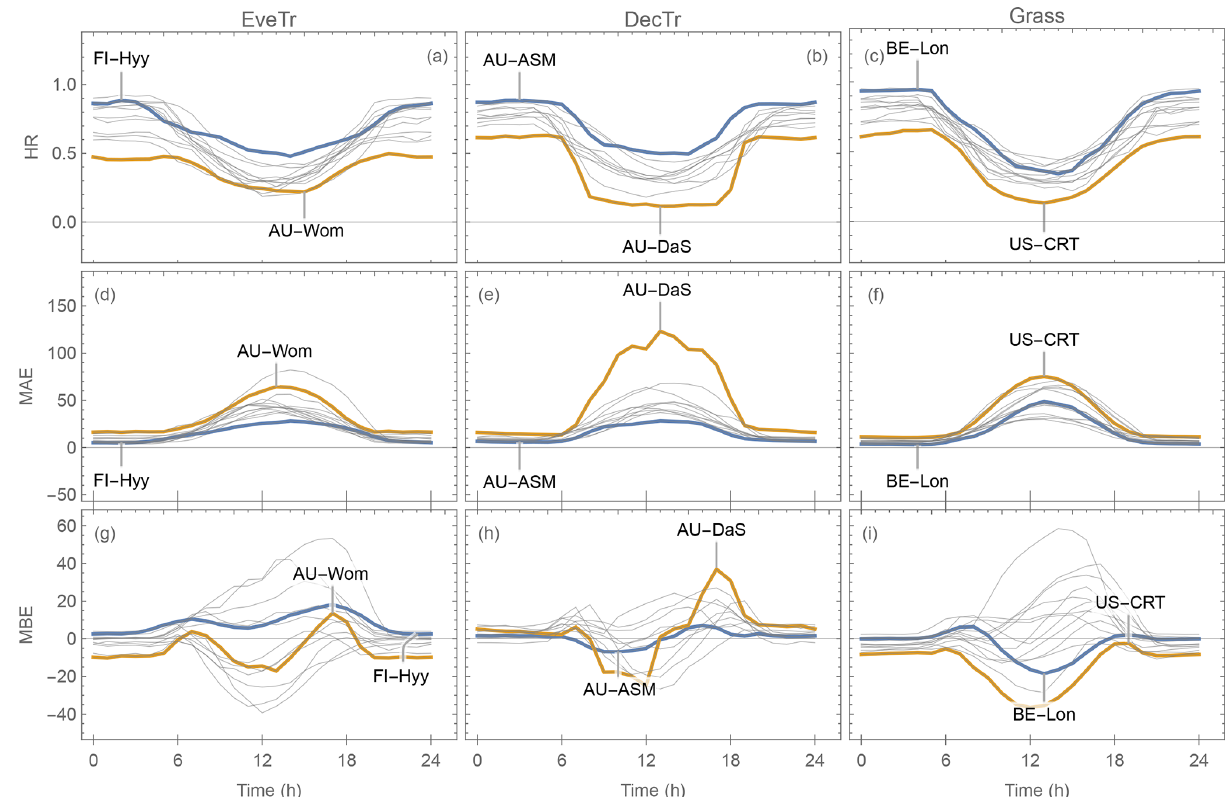
Figure 17. As Fig. 16, but for diurnal cycles using local standard